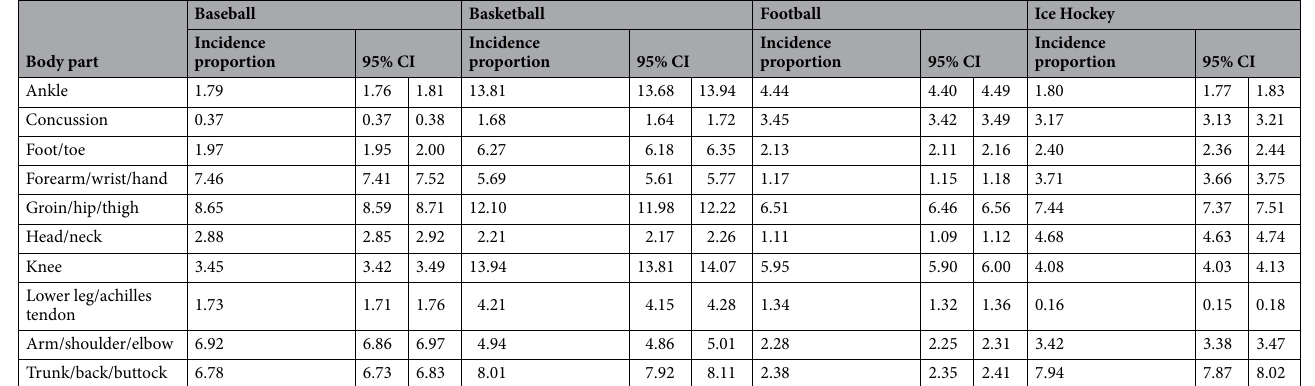
Table 1. Mean proportional incidence with 95% confidence intervals per 100 players body part and sport. 95% CI 95% confidence